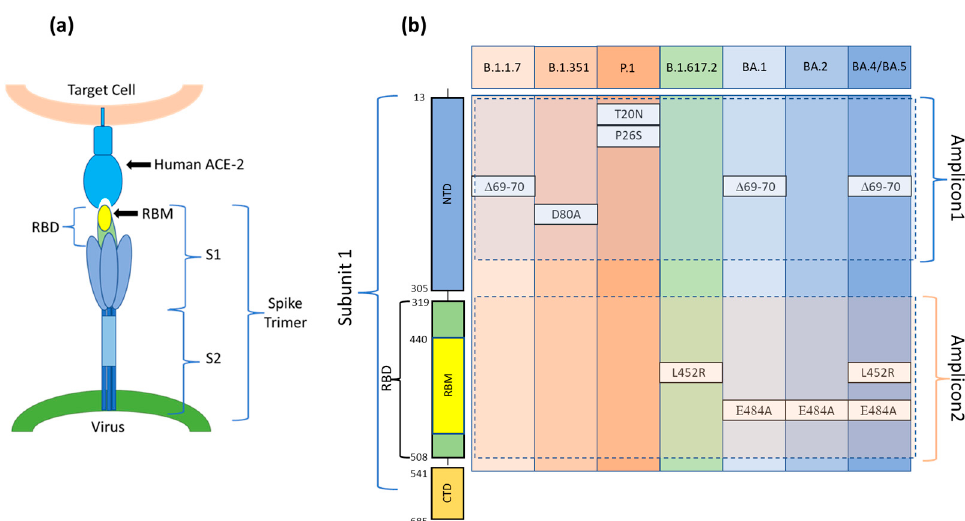
Figure 1. ( a ) The Spike protein is made up of three spike monomers which form a homotrimeric structure (Spike trimer) on the SARS-CoV-2 surface. Each spike monomer is divided into two subunits, i.e., S1 and S2, connected at the Furin cleavage site. During viral fusion, the receptor binding domain (RBD) in the S1 subunit binds to the host cell target receptor ACE2, whereas the S2 domain enables membrane fusion. ( b ) A schematic diagram and aminoacidic sequence of the S1 subunit of the SARS-CoV-2 S protein. Positions of the mutations present in each of the variants and included in Amplicon1 (positions 23 to 289 nt in the S protein coding sequence) and Amplicon2 (positions 1215 to 1545 nt in the S protein coding sequence). S1: Ectodomain S1 subunit; S2: Ectodomain S2 subunit; NTD: N-terminal domain; RBD: Receptor binding domain; RBM: Receptor binding motif; CTD: C-terminal domain.